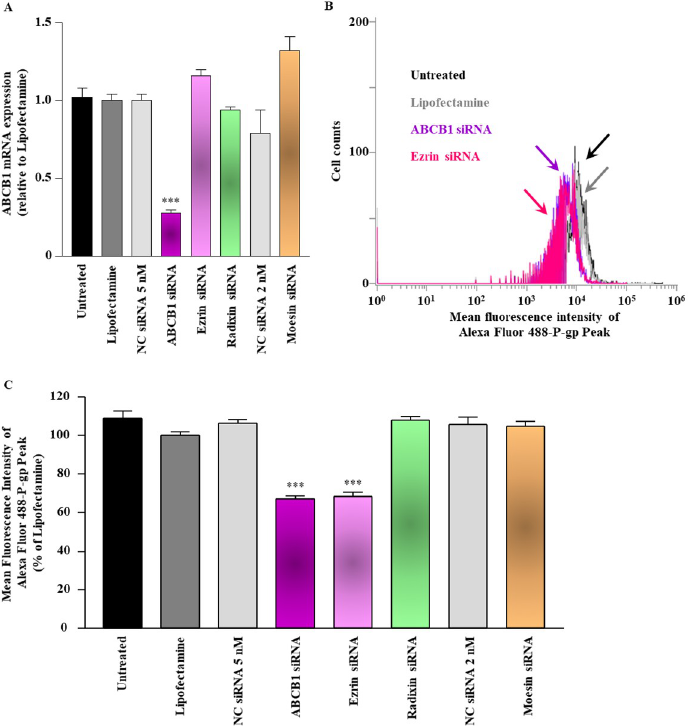
Fig 3. Effect of siRNAs targeting ezrin, radixin, or moesin on the ABCB1 mRNA and P-gp expression on the surface of LS180 cells. Cells were treated with the transfection medium (Untreated), transfection reagent (Lipofectamine), nontargeting control (NC) siRNA, and specific siRNAs for ABCB1, ezrin, radixin, or moesin and then incubated for 3 days. (A) The expression of ABCB1 mRNA in cells treated with each siRNA relative to that in cells treated with the transfection reagent alone was determined by real-time quantitative reverse transcription-polymerase chain reaction. n = 3, ��� p < 0.001 vs. Lipofectamine. (B) An overlay of the representative histograms for the expression peak of Alexa Fluor 488-labeled P-gp on the surface of the plasma membrane of LS180 cells treated with the transfection medium (Untreated; black line), transfection reagent (Lipofectamine; gray line), ABCB1 siRNA (purple line), and ezrin siRNA (pink line), as measured by flow cytometry. The calculated relative mean fluorescence intensity peaks of P-gp on the surface of the plasma membrane for all the treatments are shown in (C). n = 4, ��� p < 0.001 vs. Lipofectamine. All data are expressed as the mean ± SEM and were analyzed by a one-way ANOVA followed by Tukey’s test.